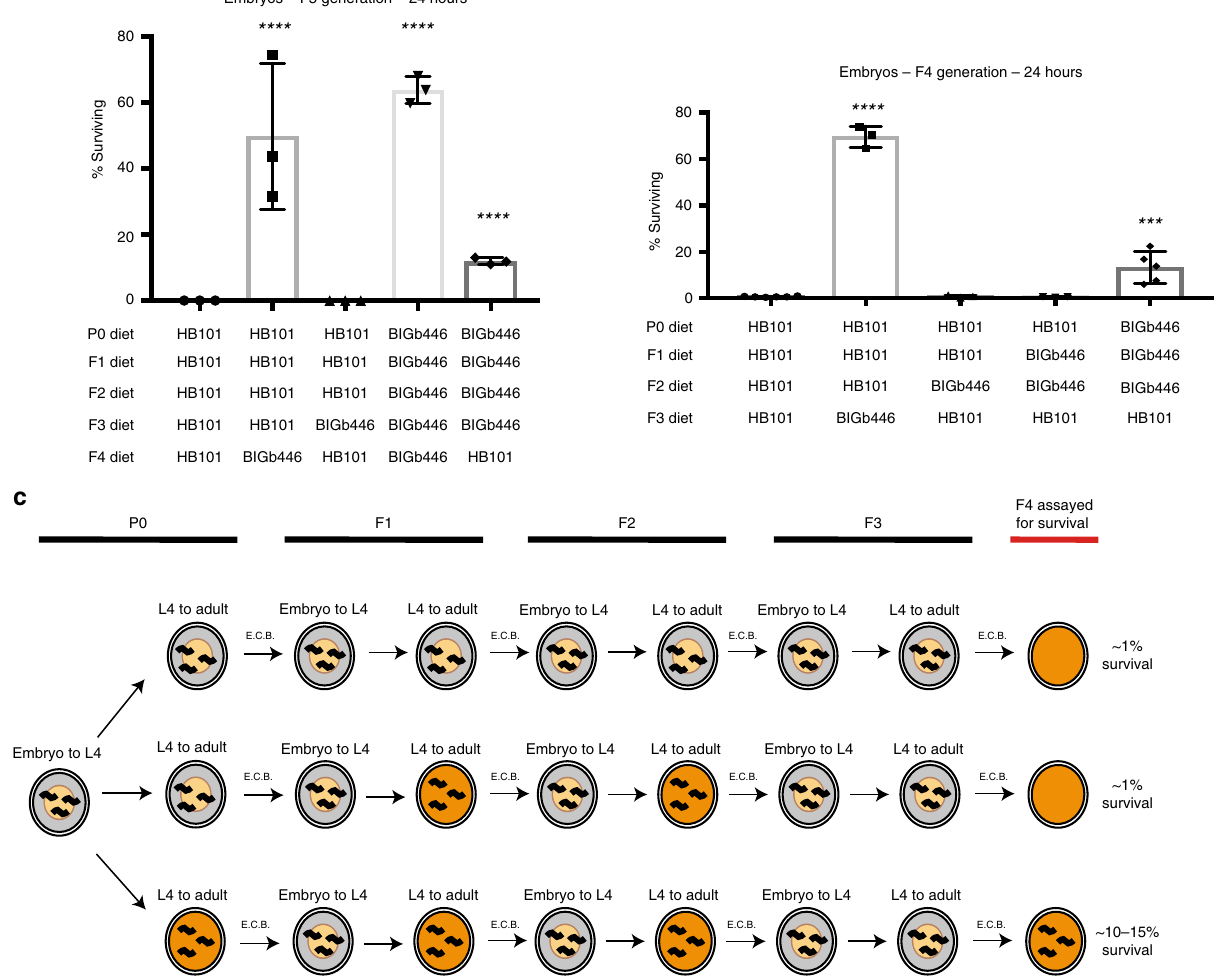
Fig. 2 C. elegans exposure to P. vranovensis can have multigenerational effects. a Percent of wild-type animals surviving on plates seeded with bacterial isolate BIGb446 after 24 h. Data presented as mean values ± s.d. n = 3 experiments of >100 animals. b Percent of wild-type animals surviving on plates seeded with bacterial isolate BIGb446 after 24 h. Data presented as mean values ± s.d. n = 3 – 6 experiments of 500 animals each. Wild-type animals carried the integrated transgene nIs470 . c Graphical representation of multigenerational experimental set up. See Fig. 1a for legend. Embryos were collected by bleaching (E.C.B.) in each generation and were placed onto fresh plates seeded with E. coli HB101 until the L4 developmental stage at each generation until the fi nal generation, where animals were placed onto fresh plates seeded with P. vranovensis BIGb446 and the percent of surviving animals was counted after 24 h. Source data are provided as a Source Data fi le. *** p = 0.003, **** p < 0.0001. See section “ statistics and reproducibility ” for statistical tests